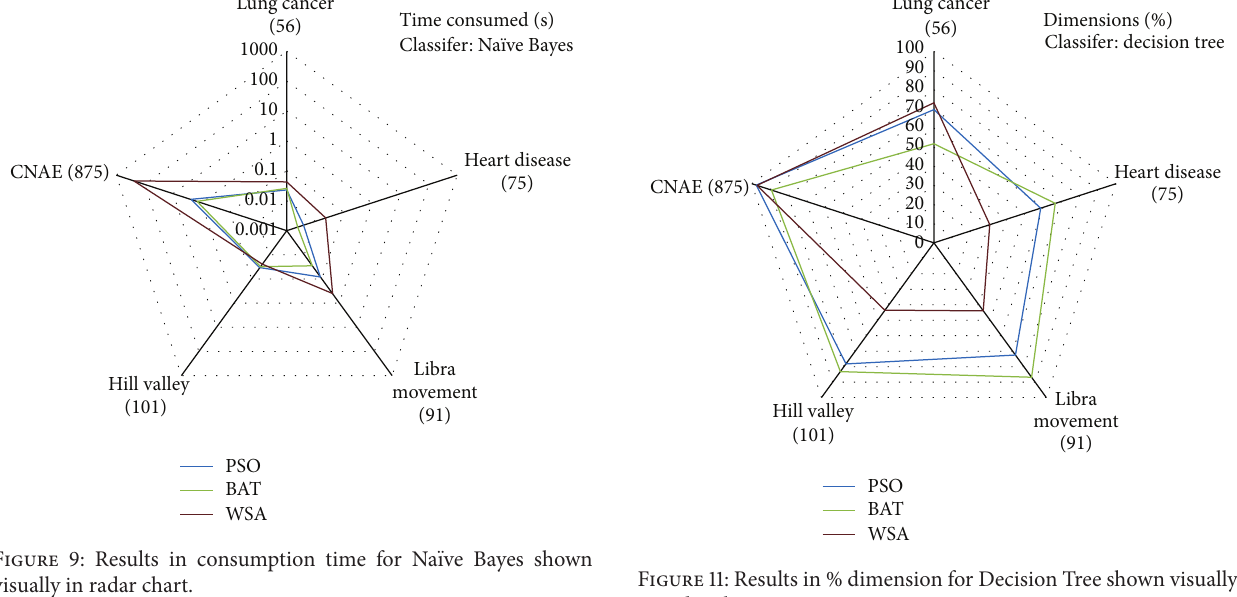
Figure 11: Results in % dimension for Decision Tree shown visually in radar chart.